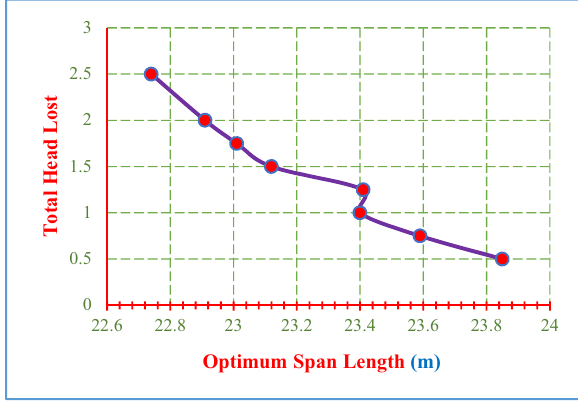
Figure 12: Total head lost vs safe span